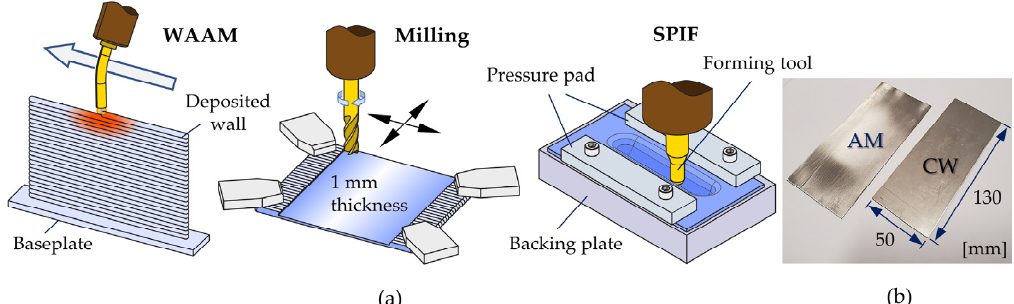
Figure 2. ( a ) Schematic representation of the hybrid manufacturing route to produce the AISI 316L stainless-steel sheets with stiffening grooves. ( b ) Photograph showing the additively manufactured and wrought commercial sheets before creating the stiffening grooves.